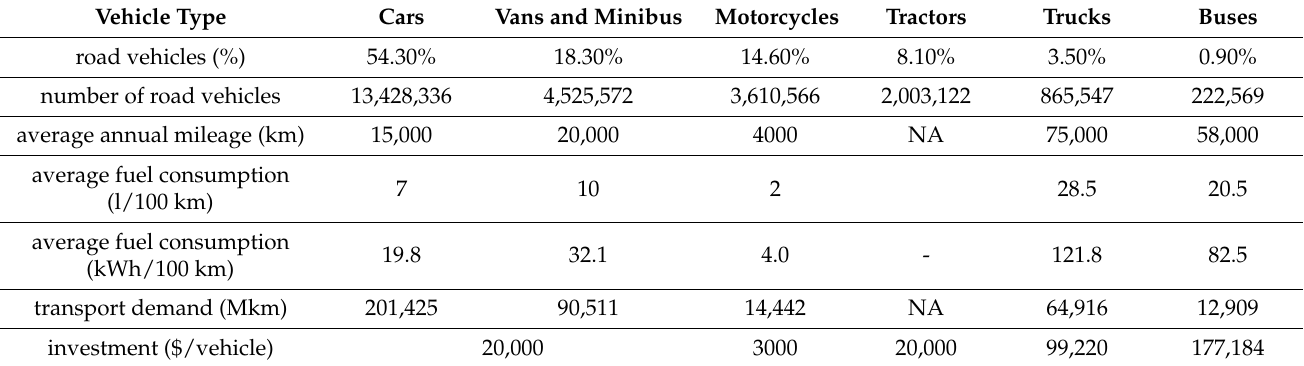
Table 2. Vehicle cost assumptions and detailed breakdown of the Turkish transport sector for